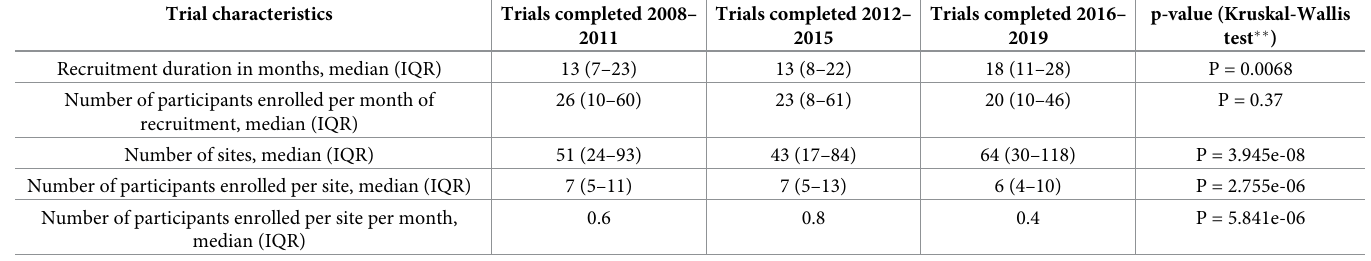
Table 2. Key recruitment characteristics of industry-sponsored phase III trials with “drug” as intervention conducted during 2008–2019. Over time development of recruitment duration, recruitment rate, number of sites and site effectiveness are presented in the table together with corresponding p-values. Trial